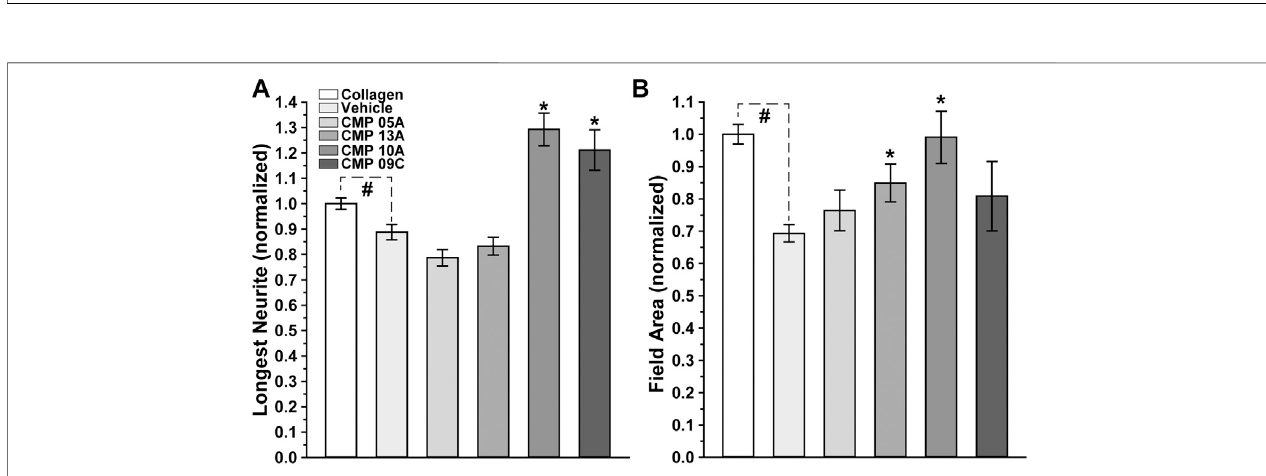
FIGURE 4 | Neurite Outgrowth Following CMP Treatment. Longest neurite outgrowth (A) and explant fi eld area (B) at 48 h normalized to their values for intact collagen (n (cid:1) 178). Explants plated on digested collagen and treated with vehicle only (n (cid:1) 139) demonstrate signi fi cantly diminished neurite length ( p (cid:1) 0.014) and fi eld area ( p < 0.001) compared to intact collagen (#). Treatment with CMPs 10A (n-17) and 09C (n (cid:1) 16) extended the longest neurites, signi fi cantly beyond even intact collagen (*, p ≤ 0.036), while CMPs 13A (n (cid:1) 17) and 10A increased fi eld area compared to vehicle (*, p ≤ 0.03).